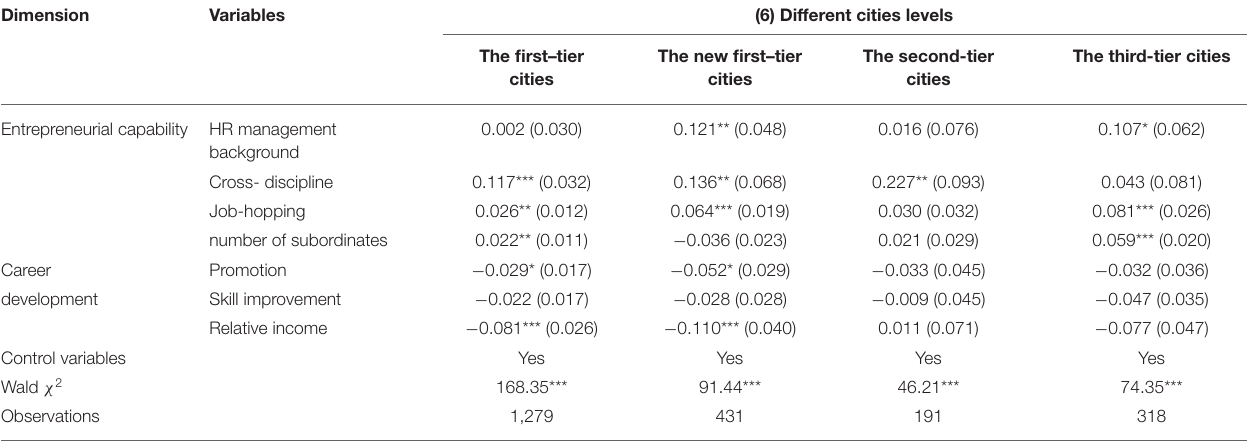
TABLE 6 | Heterogeneous analysis results in different cities levels. Dimension Variables (6) Different cities levels